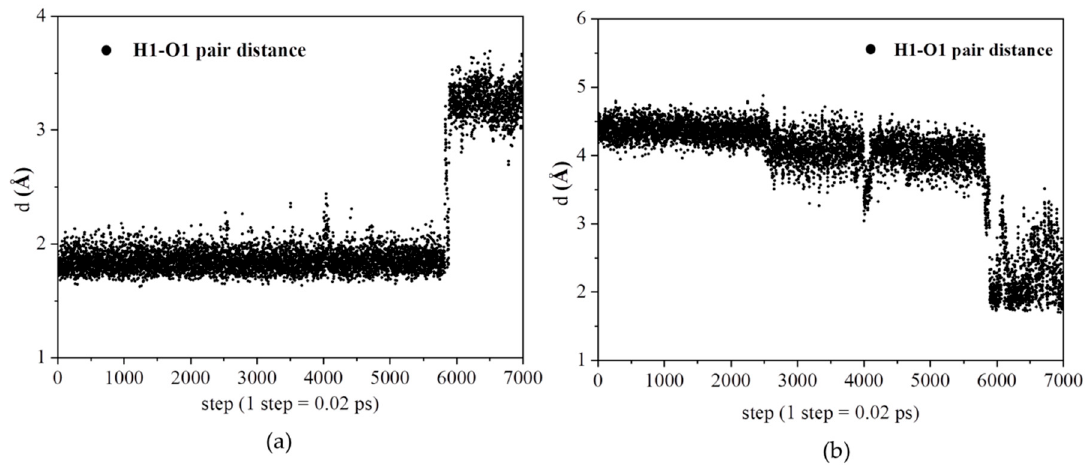
Figure 10. ( a ) The relative distance of a selected proton with ON1 (N1-O1 in PVPA). ( b ) The relative distance of a selected proton with ON2 (ON2 in PVPA).